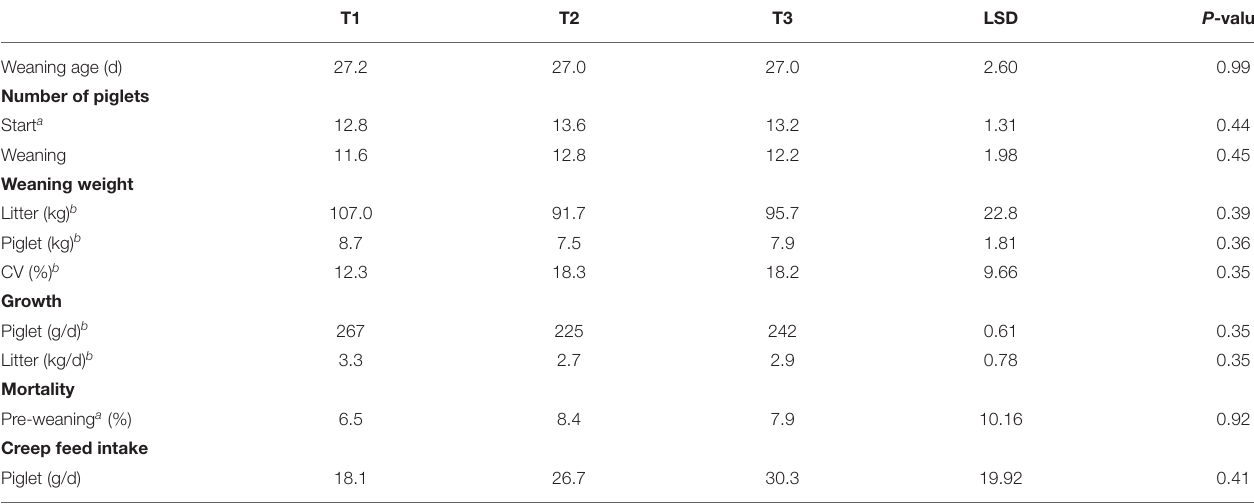
TABLE 5 | Effect of dietary treatment on piglet performance. T1 T2 T3 LSD P -value Weaning age (d)